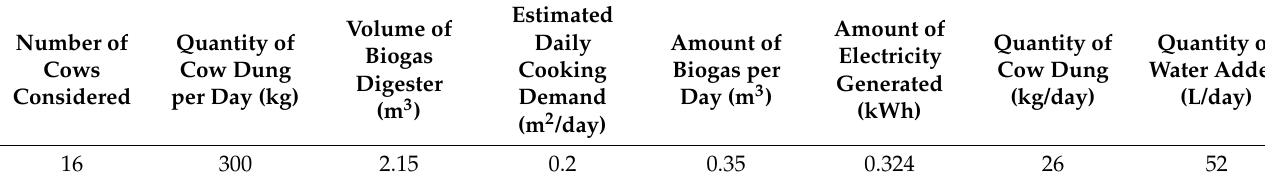
Table 2. Summary of cost analysis of the study.